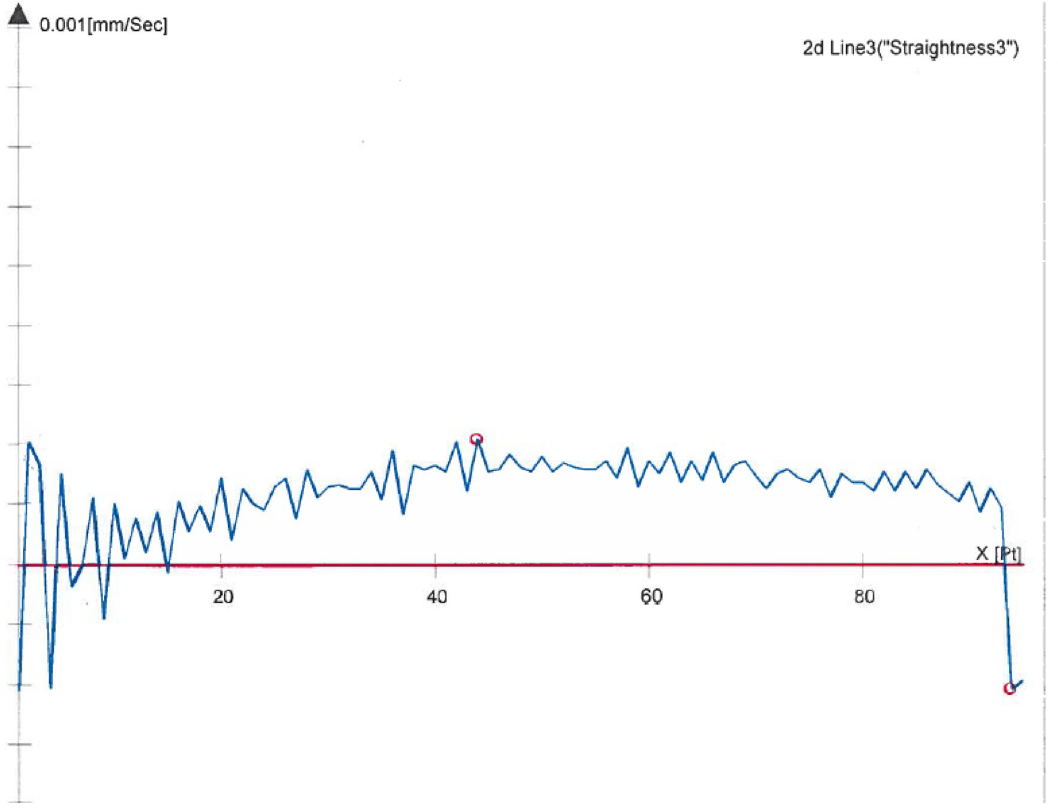
Figure 5. Profile of prism side under atmospheric conditions.